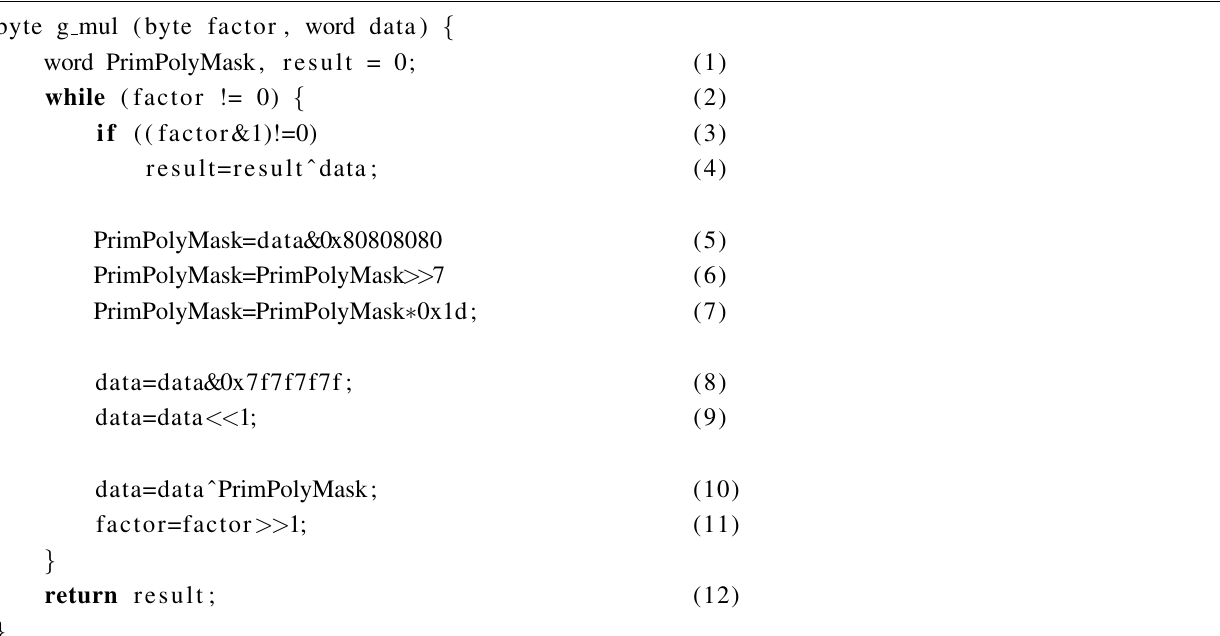
Figure 8. Optimized loop-based multiplication of GF( 2 8 ) for GPU.